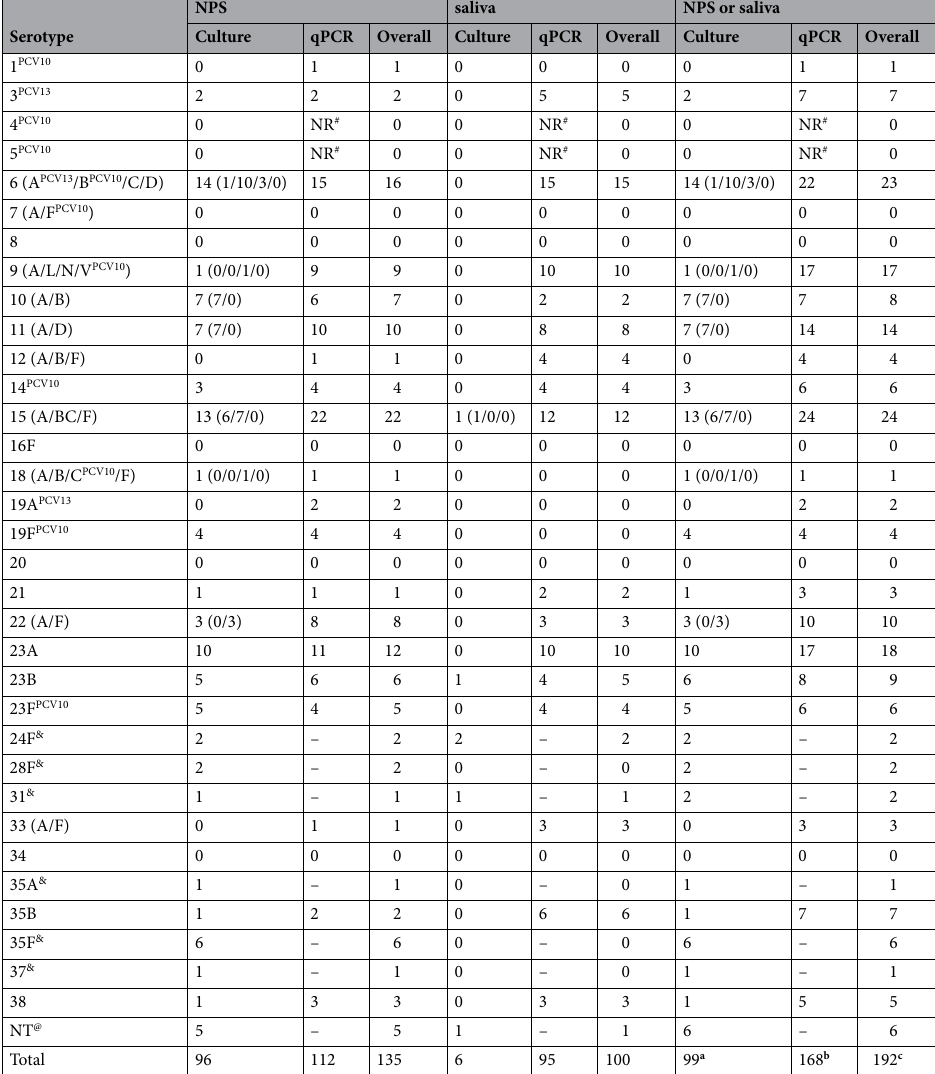
Table 3. Serotypes of strains cultured in the study or detected using serotype-specific and serogroup-specific qPCRs. # An assay of insufficient specificity thus considered to be not reliable (NR), & serotypes not targeted by qPCR, thus detected by culture alone, @ non-typeable S. pneumoniae strains, a number of S. pneumoniae strains cultured from 97 carriers, b number of serotypes detected in 155 individuals identified as carriers of S. pneumoniae by molecular method (qPCR), c number of serotypes detected in 158 individuals identified as carriers of S. pneumoniae by any method used in the study, PCV10 serotype targeted by PCV10 and PCV13, PCV13 serotype targeted only by